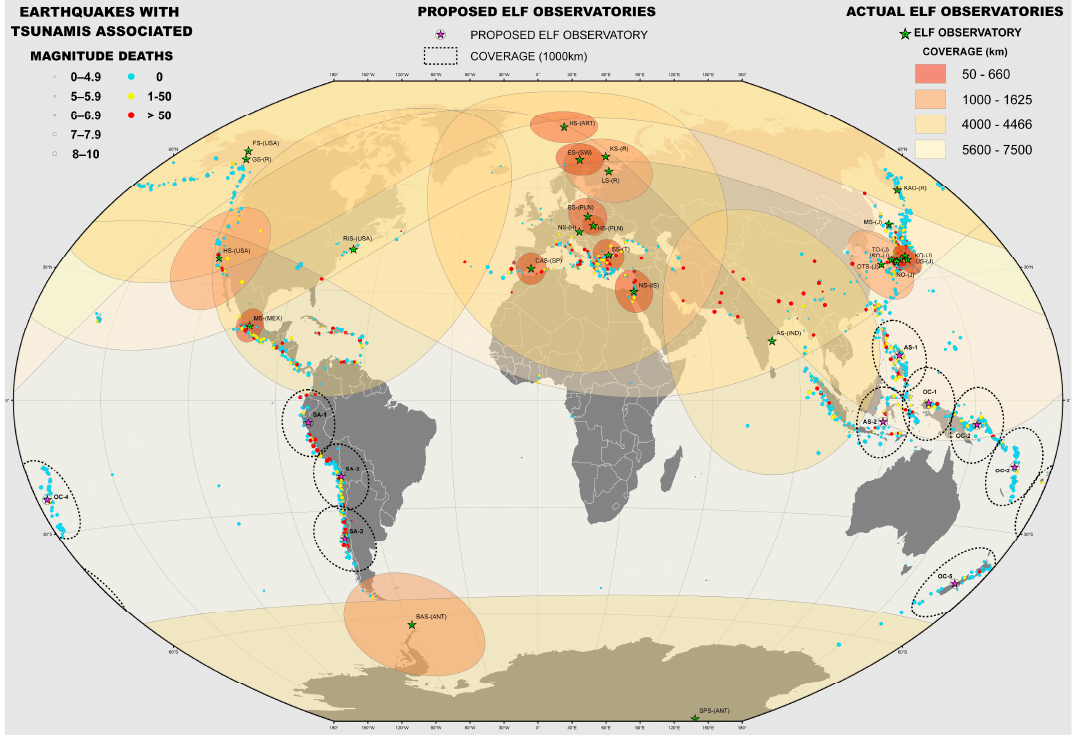
Figure 6. Tsunami risk alerts worldwide through proposed ELF observatories with a 1000 km of ratio. Table 2. Proposed ELF Observatories (1000 km).